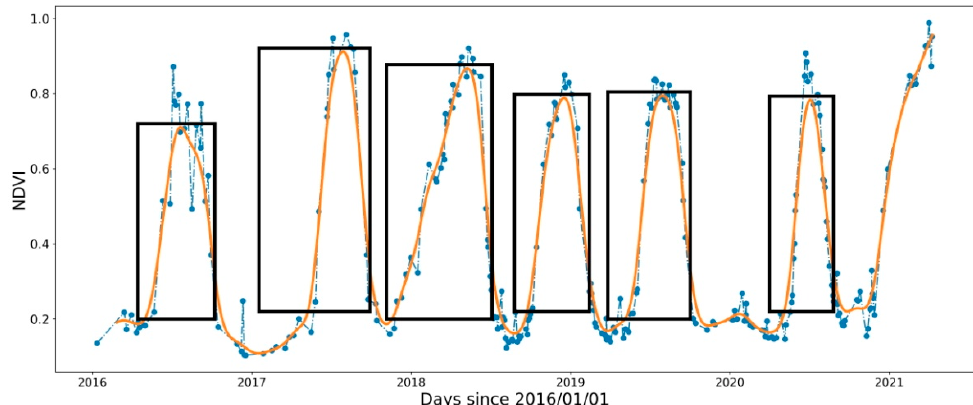
Figure 5. Example of identification of the start and end of the crop season from Sentinel-2 NDVI time series. The dashed blue line is the original Sentinel-2 time series of NDVI. The orange line is the filtered NDVI. The black boxes are the estimated crop seasons.